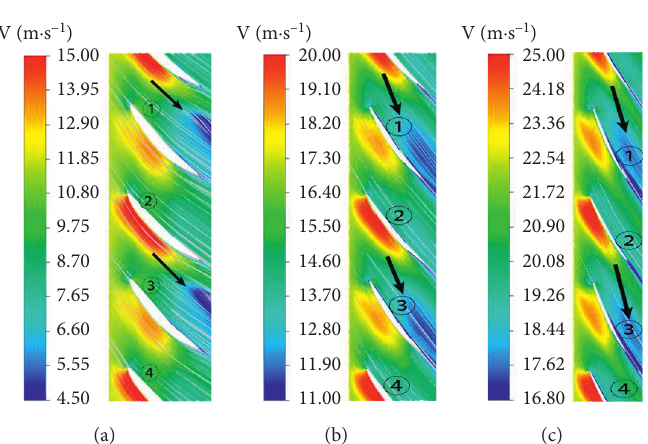
Figure 12: The velocity streamline of each span in Scheme II ( Q � Q